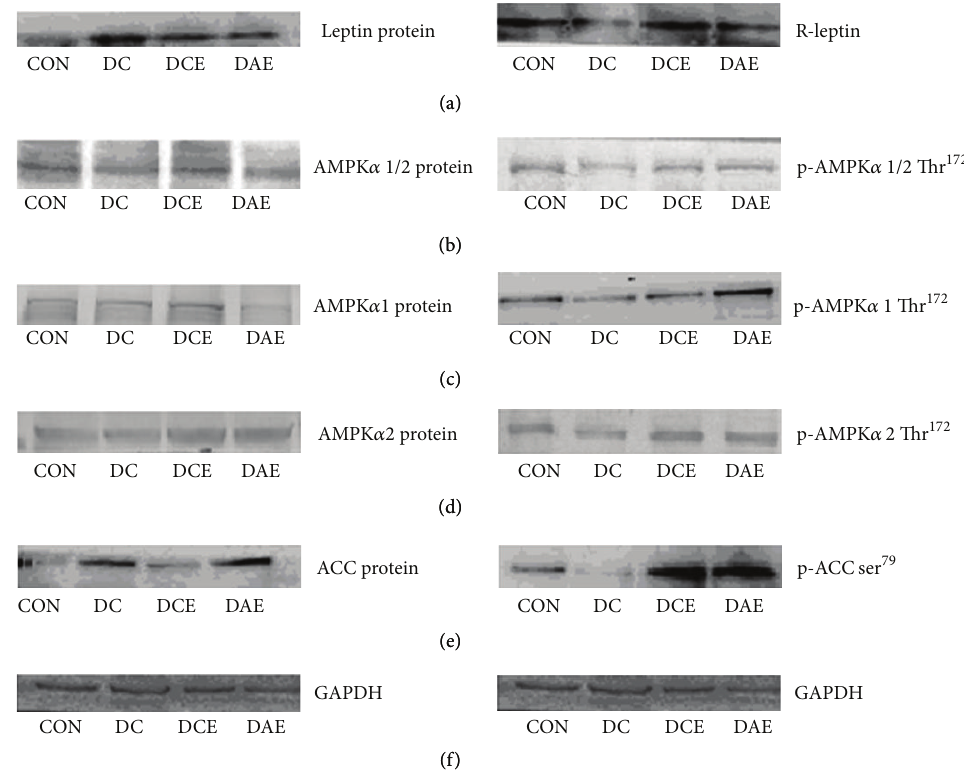
Figure 2: Western blotting images of protein expression and protein phosphorylation related to the leptin-AMPK-ACC signaling pathway of different groups of type 2 diabetes rats. (a) Leptin and its receptor. (b) AMPK 𝛼 1/2 and p-AMPK 𝛼 1/2. (c) AMPK 𝛼 1 and p-AMPK 𝛼 1. (d) AMPK 𝛼 2 and p-AMPK 𝛼 2. (e) ACC and p-ACC. (f) GADPH as an internal standard.